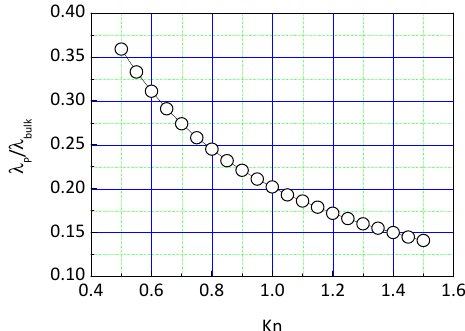
Figure 2. Knudson number ( Kn ) influence on thermal conductivity of primary particle chains.